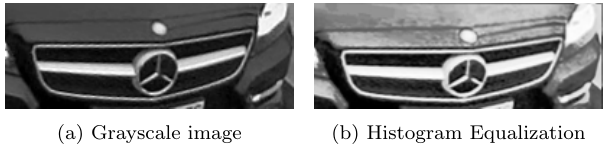
Figure 6: Histogram equalization of a grayscale